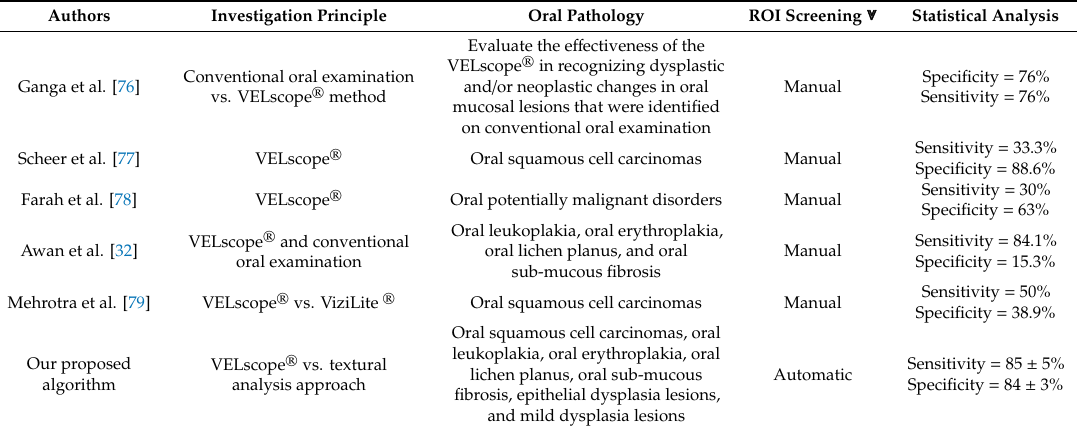
Table 6. Comparison of our purposed algorithm with existing